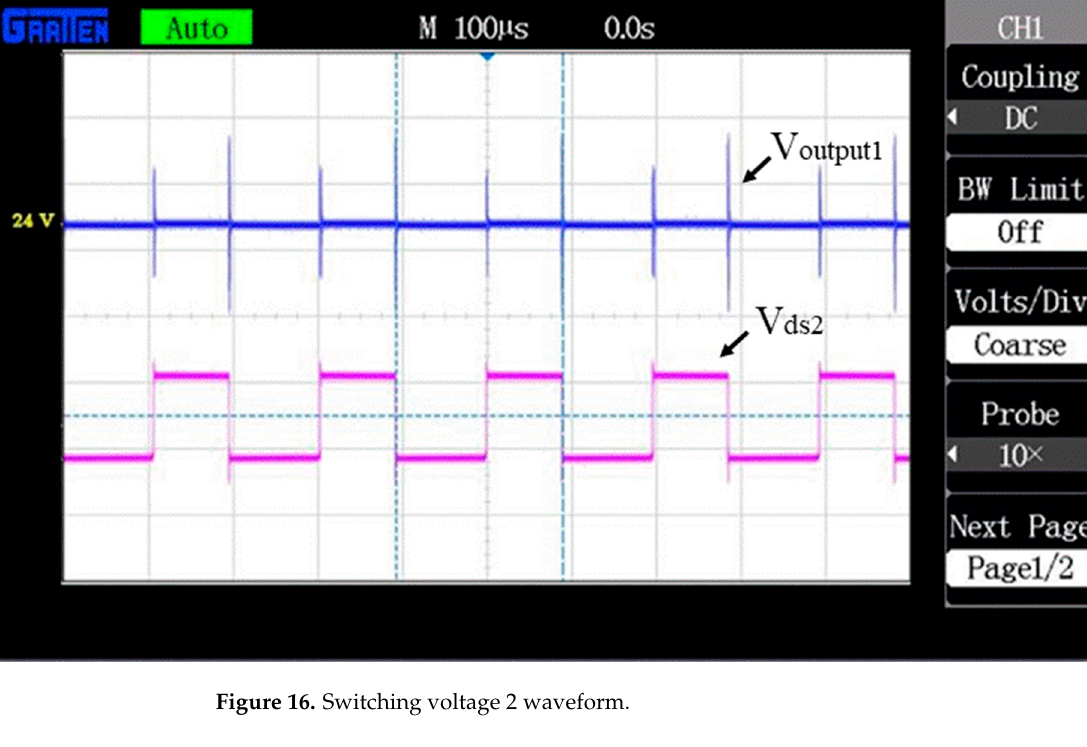
Figure 15. Inductance voltage V Lb waveform.